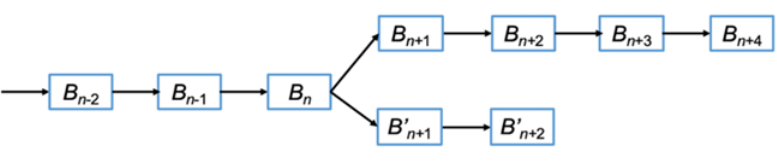
Figure 2. An example for the forked chain structure.